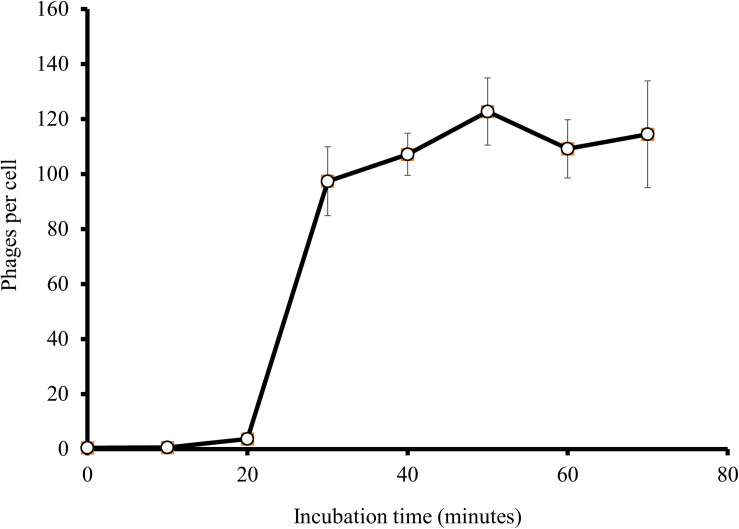
One-step growth curve of the EspM4VN.